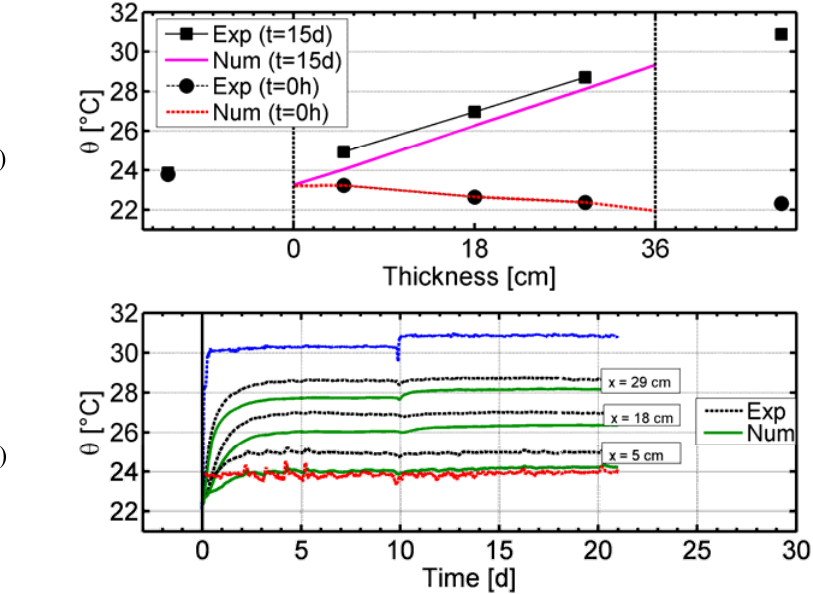
Figure 12. Comparison between experimental (black lines) and simulated (colored lines) temperature of uncoated hemp concrete wall subjected to Experiment 2. Top graph ( a ) shows the spatial response at t = 0 and 15 d; bottom graph ( b ) the transient response at x = 5, 18 and